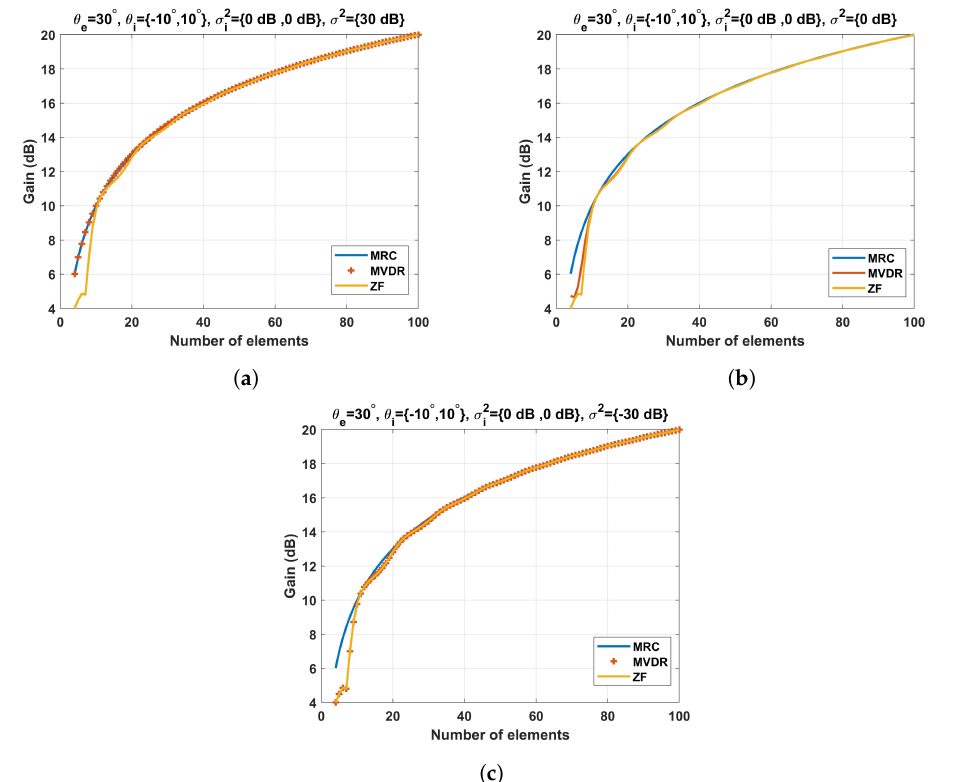
Figure 6. Beamforming techniques gain as a function of the number of array elements and the noise power: ( a ) σ 2 = 30 dB; ( b ) σ 2 = 0 dB; ( c ) σ 2 = − 30